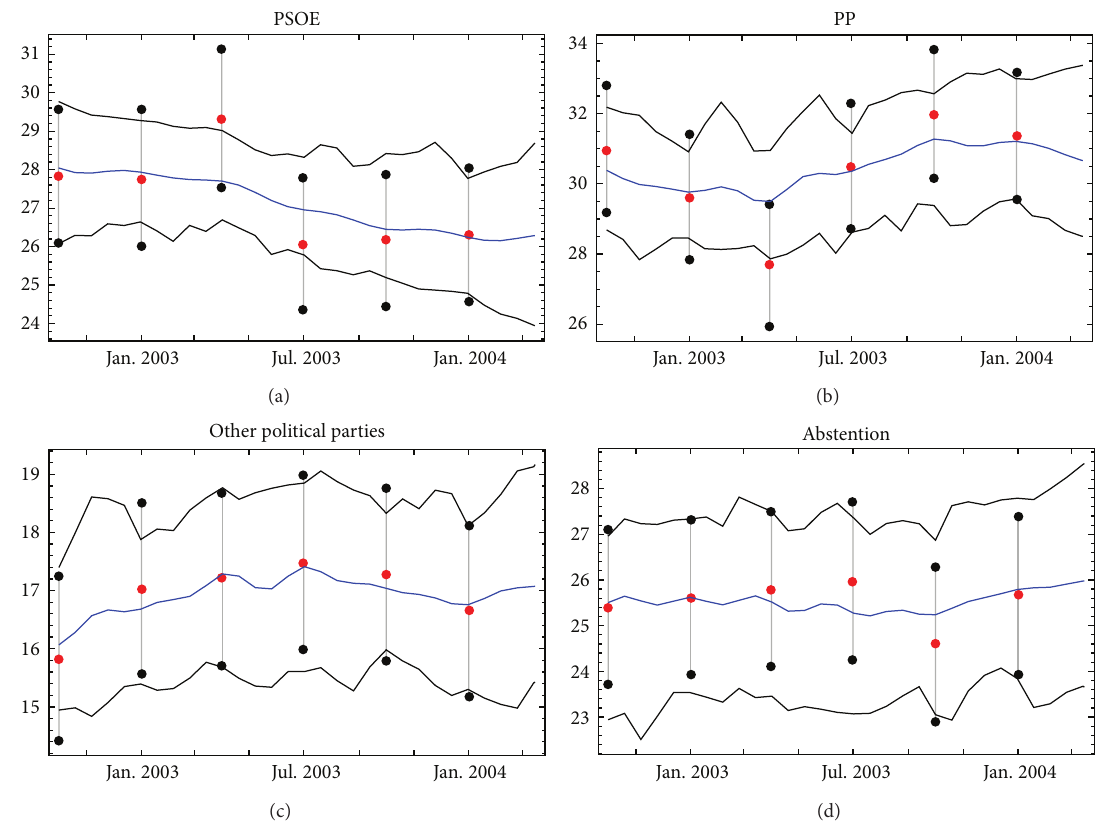
Figure 4: Probabilistic fitting. The red points and the black points determine the mean and the 95% confidence interval of the CIS surveys data, respectively. The black lines determine the 95% confidence bands obtained by the model. The blue line is the model mean. The model captures the uncertainty of the data. Data for PSOE and PP in April 2003 do not lie completely inside the band, probably because of citizen protests related to the war in Iraq.